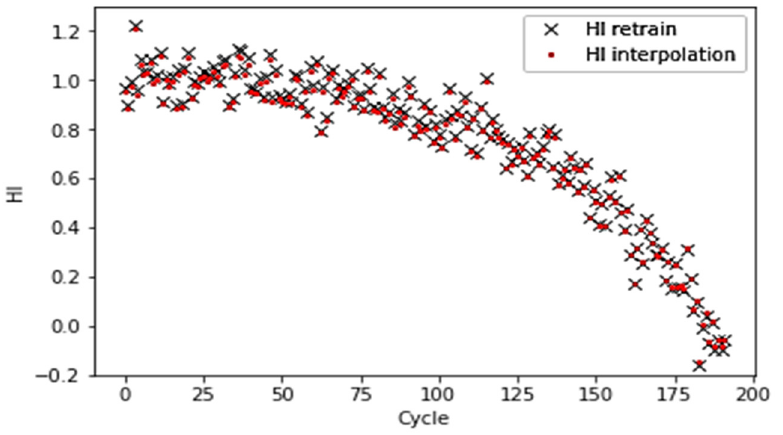
Figure 11. Retraining of the interpolated HI with a selected model (correlation coefficient r = 0.999).